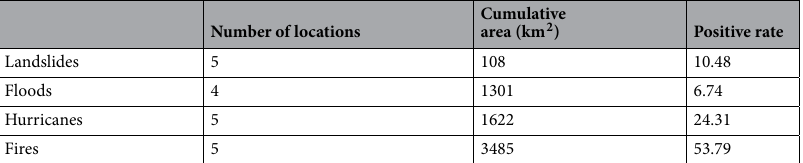
Table 1. The RaVÆn dataset statistics. Each location is captured in 4 time-steps before the event and once after the event. Positive rate denotes the ratio of changed to non-cloudy pixels in the last pair of images (the only frames that are